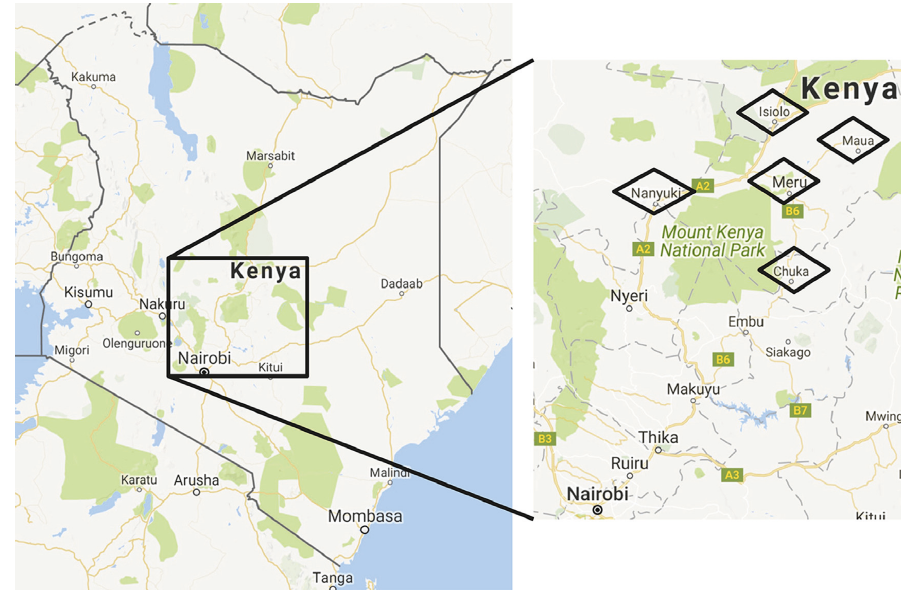
Figure 2: Map showing towns where raw vegetable salad samples were